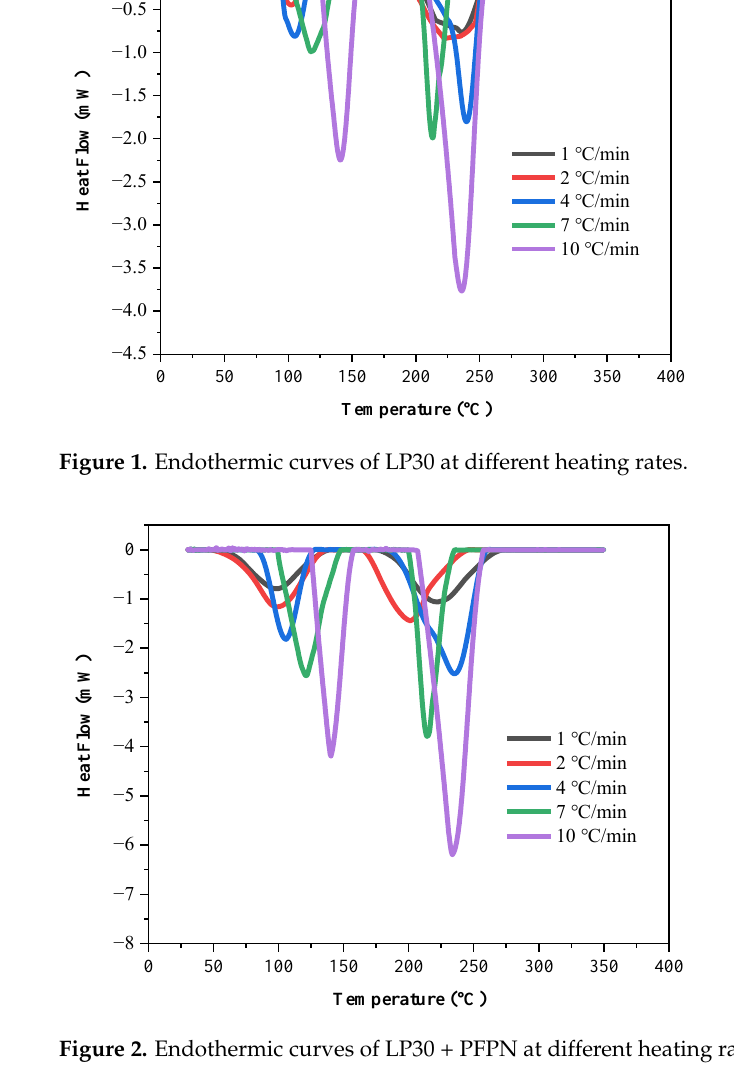
Figure 3. Endothermic curves of LP30 and LP30 + PFPN at β of 10 °C/min. To further analyze the thermal decomposition behavior of the LP30 + PFPN electro- lyte, we conducted an ARC experiment under pseudo-adiabatic conditions. The charac- teristic parameters of the experiment are listed in Table 3. As illustrated in Figures 4 and 5, when the experiment had progressed by about 1180 min, the temperature of the reaction system reached about 220 °C. At this time, the temperature of the reaction system began to rise, and the pressure also increased. As shown in Figures 6 and 7, when the experiment had been carried out for about 1225 min, the temperature of the reaction system reached about 231 °C, and the pressure reached approximately 70 bar. At this time, the heating rate and pressure rise rate reached their peak values, which were 0.51 °C/min and 1.2 bar/min, respectively. 0